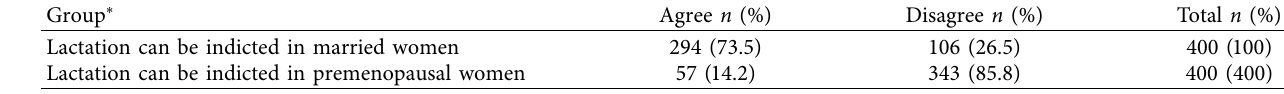
Table 6: The participants’ attitude toward induced lactation